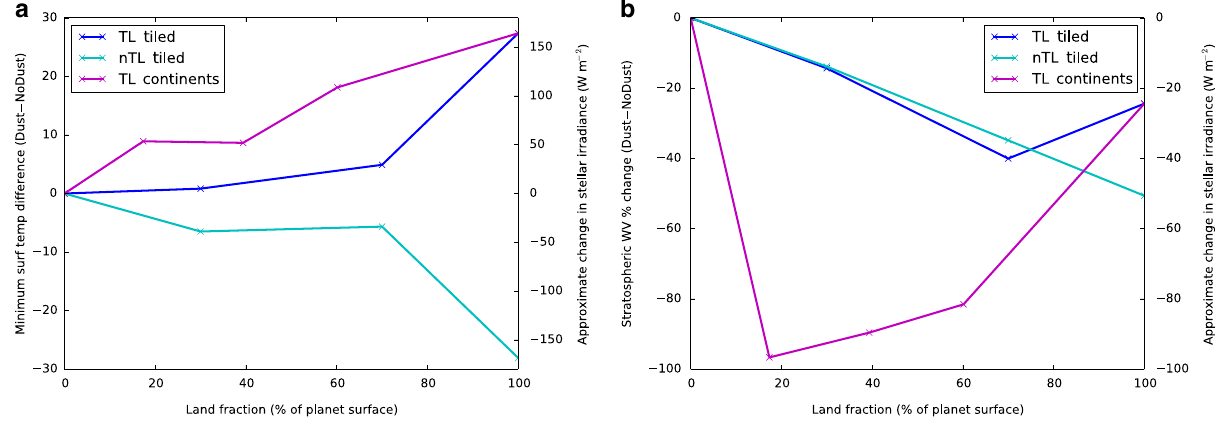
Fig. 2 Effect of dust on habitable zone boundary indicators. Differences in a minimum surface temperature, and b stratospheric ( ≈ 50 hPa) water-vapour content, between simulations with (Dust) and without (NoDust) mineral dust, as a function of land fraction. The different planetary and surface setups are shown in the legend. Approximate equivalent changes in stellar irradiance required to achieve similar responses in a dust-free planet are shown on the right